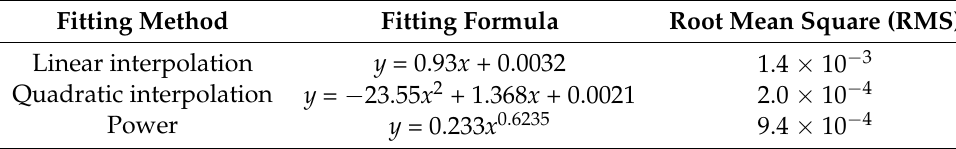
Table 7. Relationships obtained by numerical fitting.